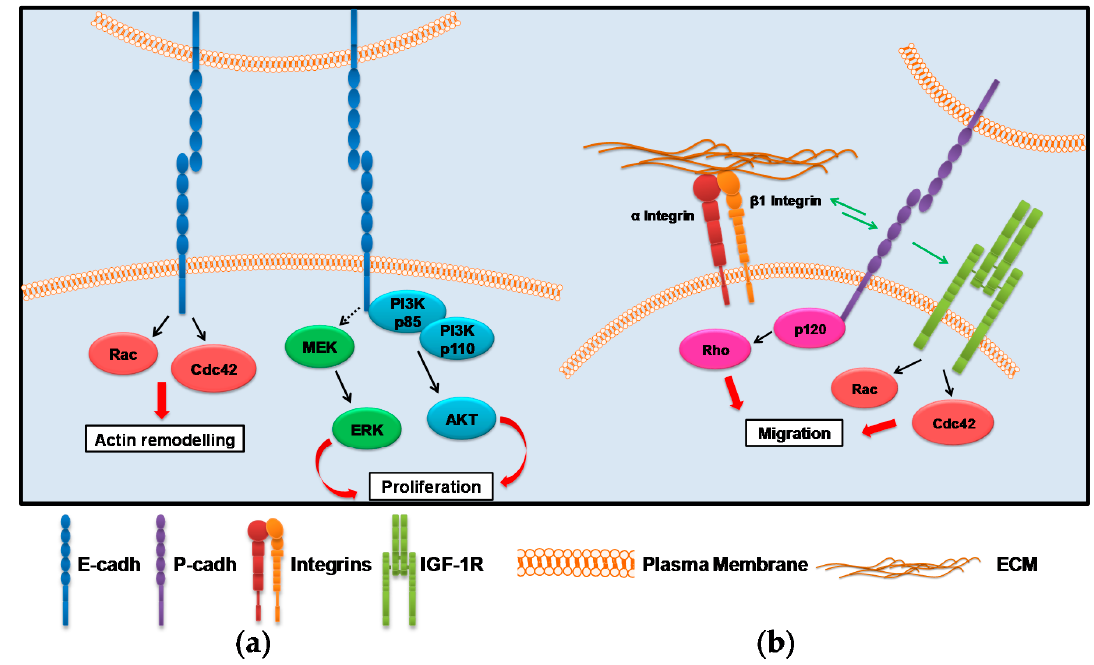
Figure 1. Schematic representation of ( a ) E- and ( b ) P-cadh-associated signaling cascades activated in EOCs (Epithelial Ovarian Cancers). The arrows indicate: green, protein-protein interaction, black, signaling cascades; discontinuous, possible signaling cascade; red, cellular effects. The abbreviation used are: cadh, cadherin; IGF-1R, Insulin Growth Factor Receptor 1; ERK, Extracellular signal-Regulated Kinase; MEK, MAP or ERK kinase; PI3K, phosphoinositide 3-kinase; p120, p120 catenin. Rho, Rac and CDC42 are Rho-GTPases.